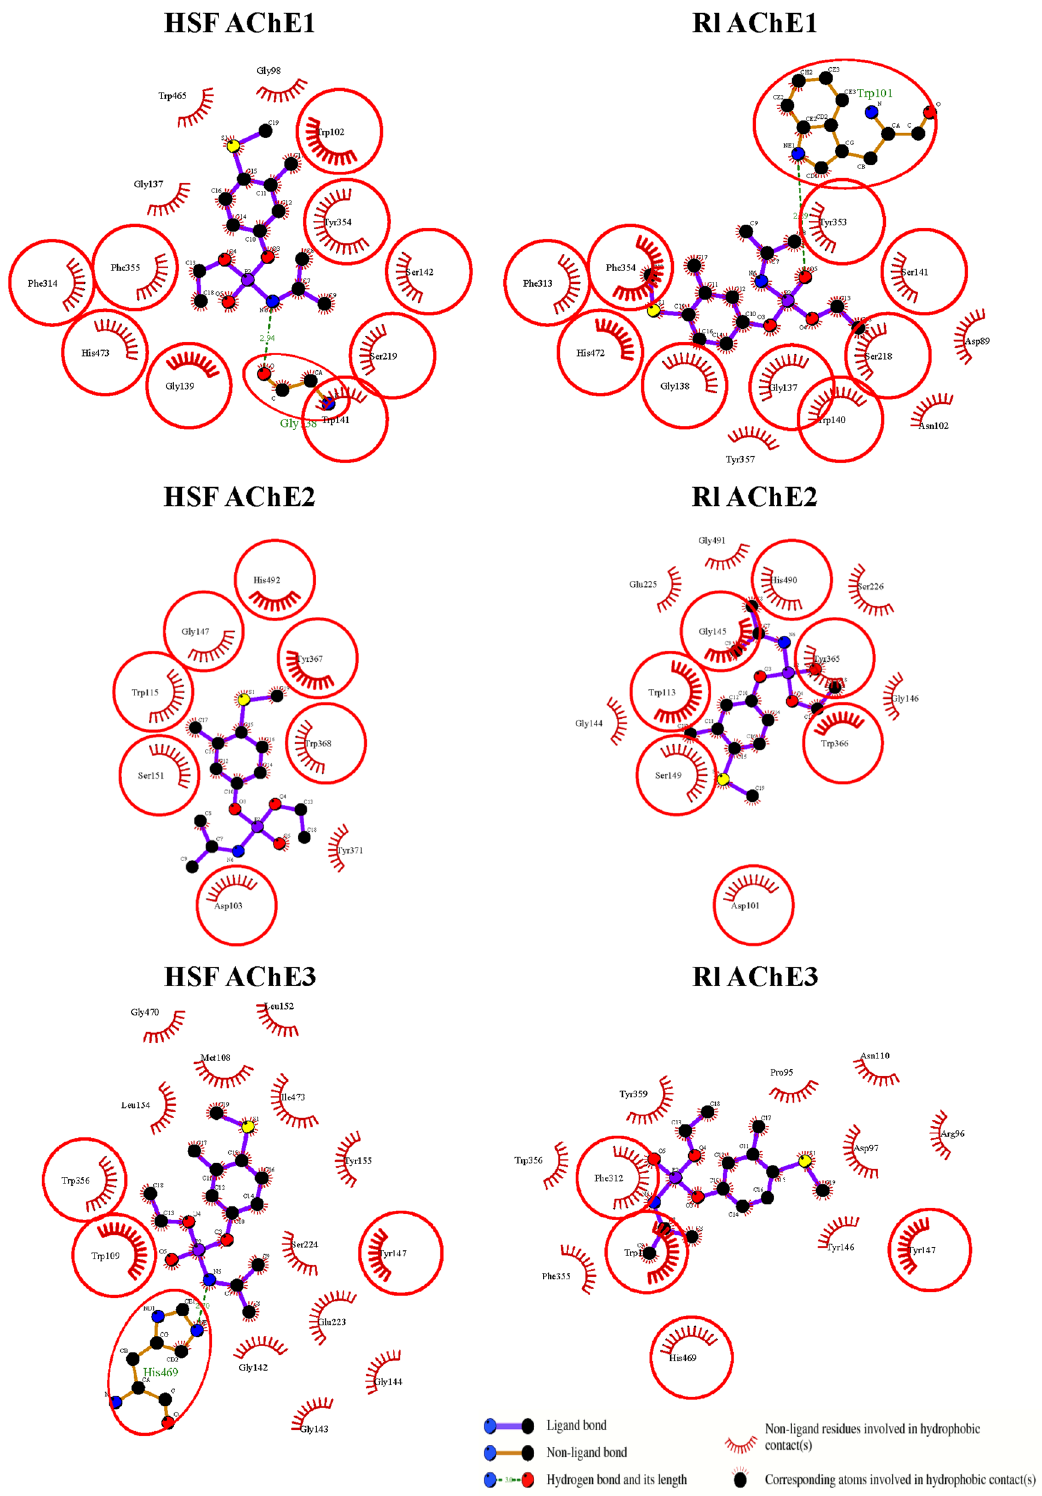
Figure 5. Schematic of possible interactions between fenamiphos and AChE-residues. The key residues surrounding the acetylcholine-binding pocket of AChE1, AChE2, and AChE3 proteins were identified via the best docking poses. The red circles and ellipses indicate the identical residues in both HSF and Rl isolates. The interaction plot was generated by using LigPlot + v.2.2.4 software 60 (https:// www. ebi. ac. uk/ thorn ton- srv/ softw are/ LigPl